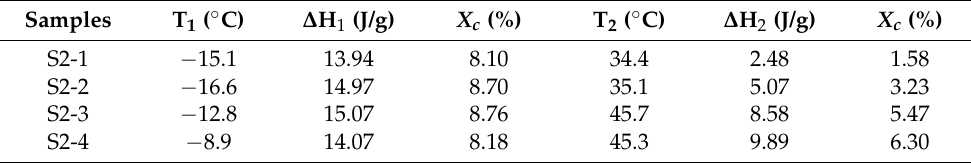
Table 7. Melting enthalpy and crystallinity of elastomers with different PEG